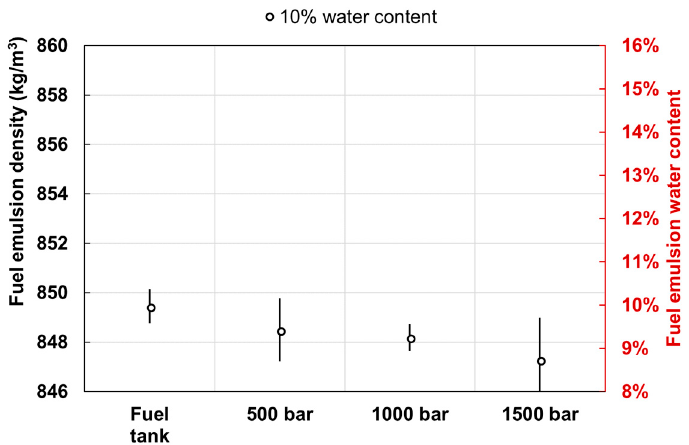
Figure 4. The density measurement of an emulsion made with 10% water content at different injection pressures. The density reduced with the increase of injection pressure as the result of a reduction in the water concentration of the emulsion.